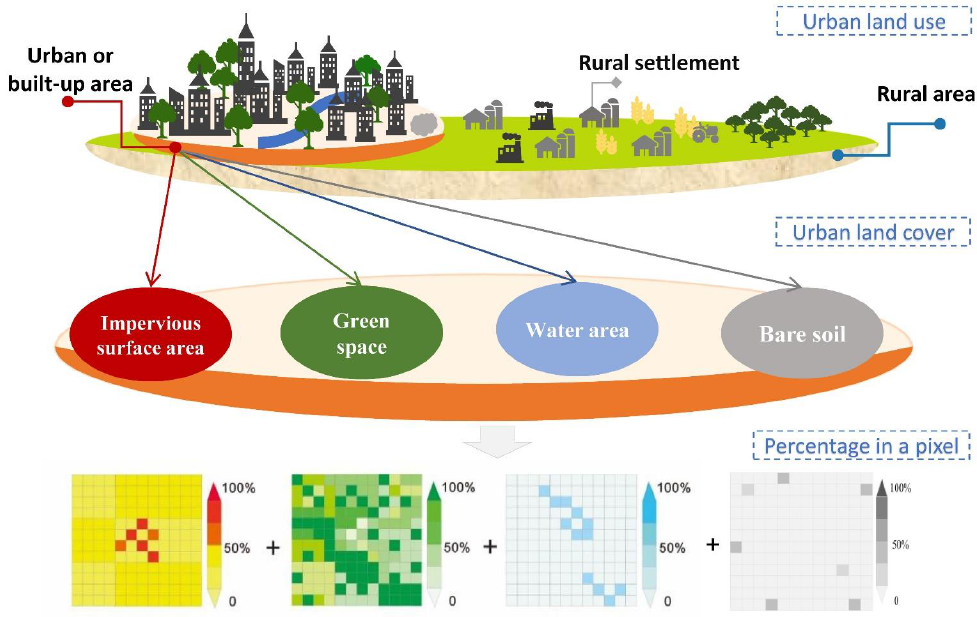
Figure 1. The hierarchical scale principle and subpixel metric method for mapping ISA and GS